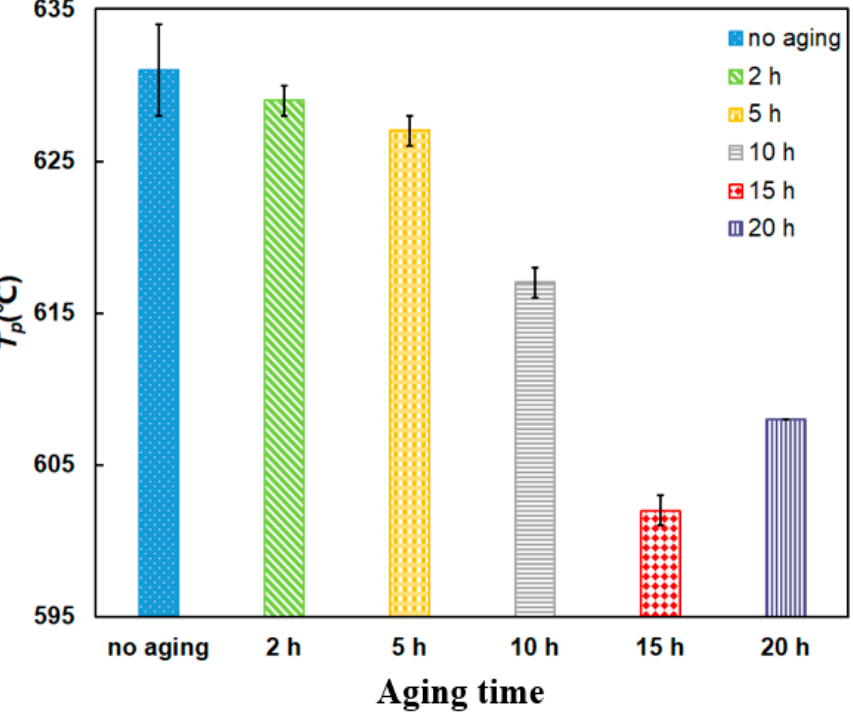
Figure 13. Comparison of T p of PU/Pt mixtures at different thermal aging times.